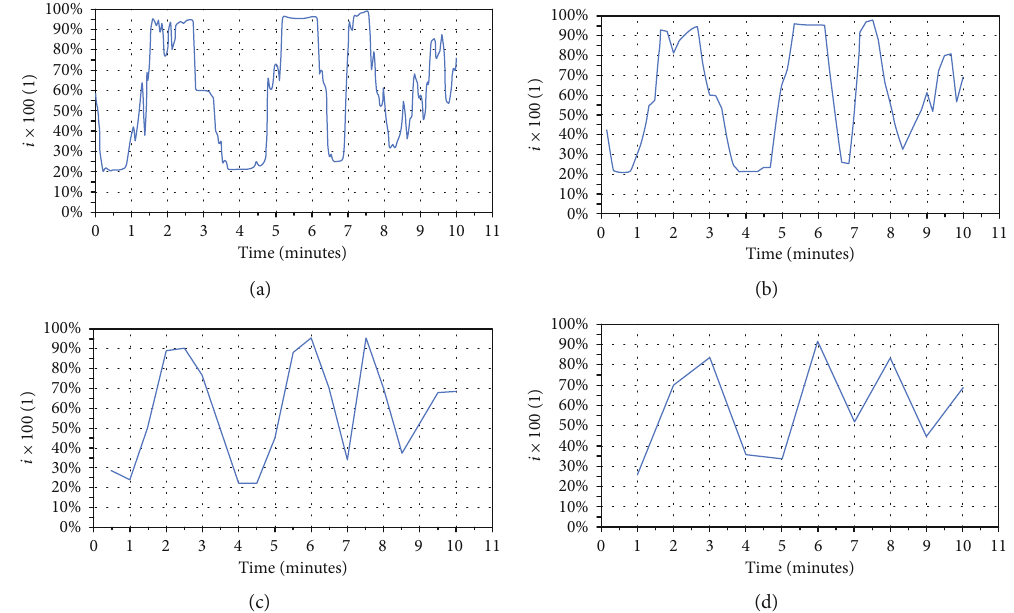
I I from the NYI observations for di ff erent averaging times: (a) one second, (b) 10 n = n / STC